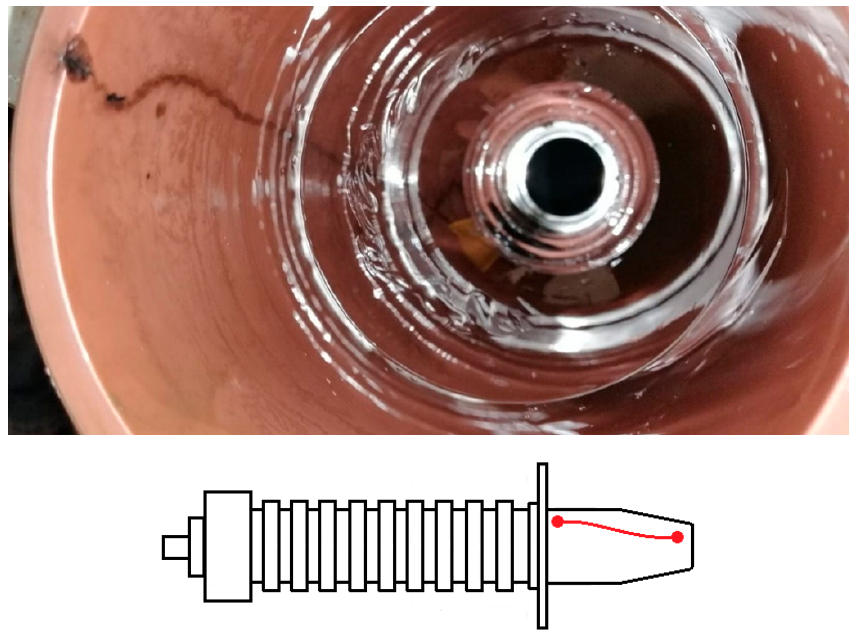
Figure 4. Visible trace of the discharge on the inside part of the epoxy housing ( top ) together with the illustrative sketch showing the development path of the discharge ( bottom ).